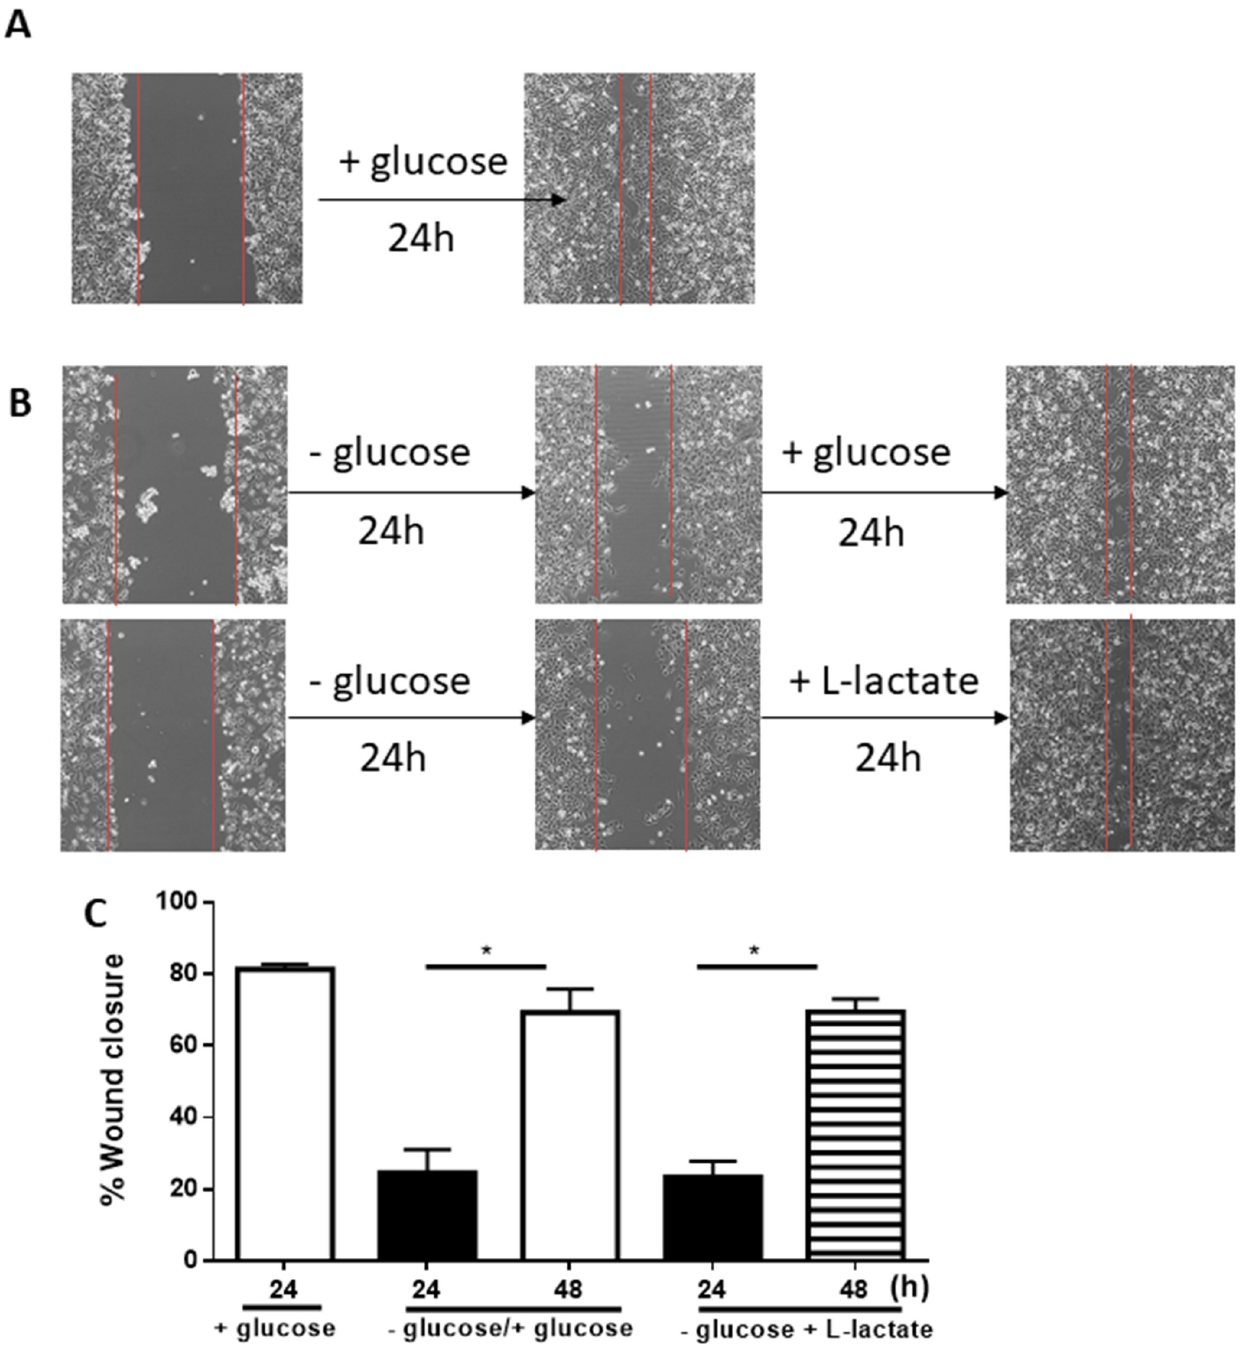
Fig 5. Effect of glucose starvation on pII cell motility. The degree of pII cell motility upon culture in + glucose medium (panel A),—glucose medium (panel B), -glucose medium for 24 h followed by culture in +glucose medium for another 24 h, or -glucose medium in the presence of 20 mM L-lactate was determined (panels B-C) as described in Methods. Histobars represent means ± SEM of at least 3 independent determinations. � denotes significant difference with p <